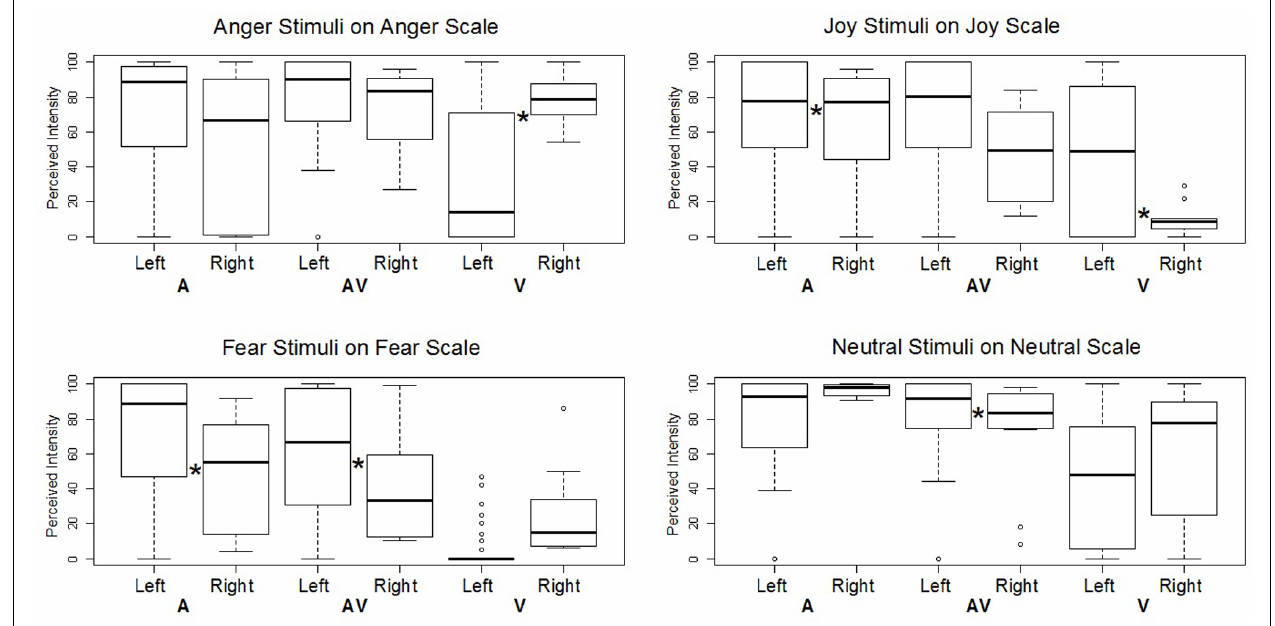
FIGURE 4 | Boxplot of GLM results for intensity ratings of each emotion on the corresponding target scale. Each box corresponds to a specific modality (A: auditory, AV: audiovisual,V: visual) and a specific patient subgroup (left lesion vs. right lesion). *Indicates a significant difference between left and right lesion